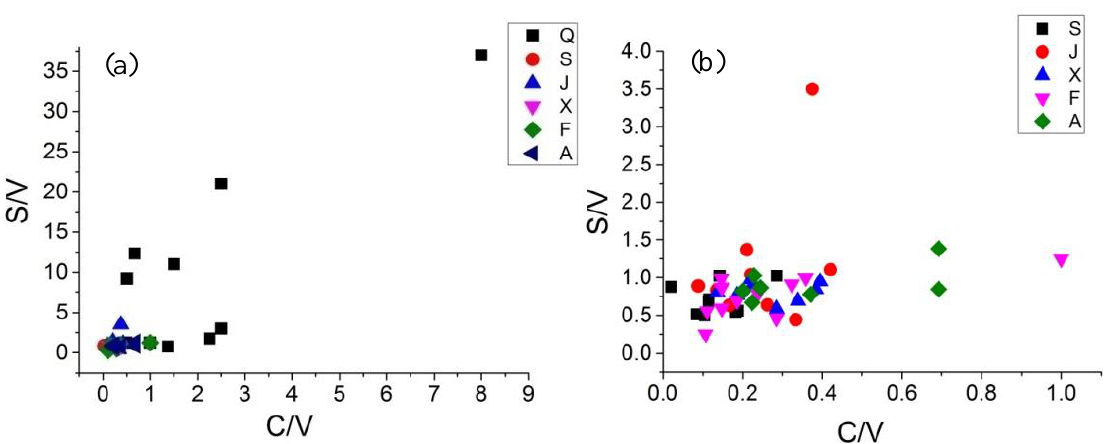
Figure 4. Plots of S/V and C/V ratio in sediments from sampling areas ( a ) including Q region, and ( b ) without Q region.